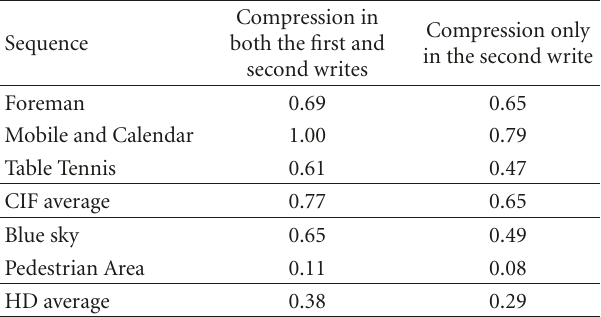
Table 5: E ff ect of compression by the first write of deblocking filter in BD-PSNR degradation